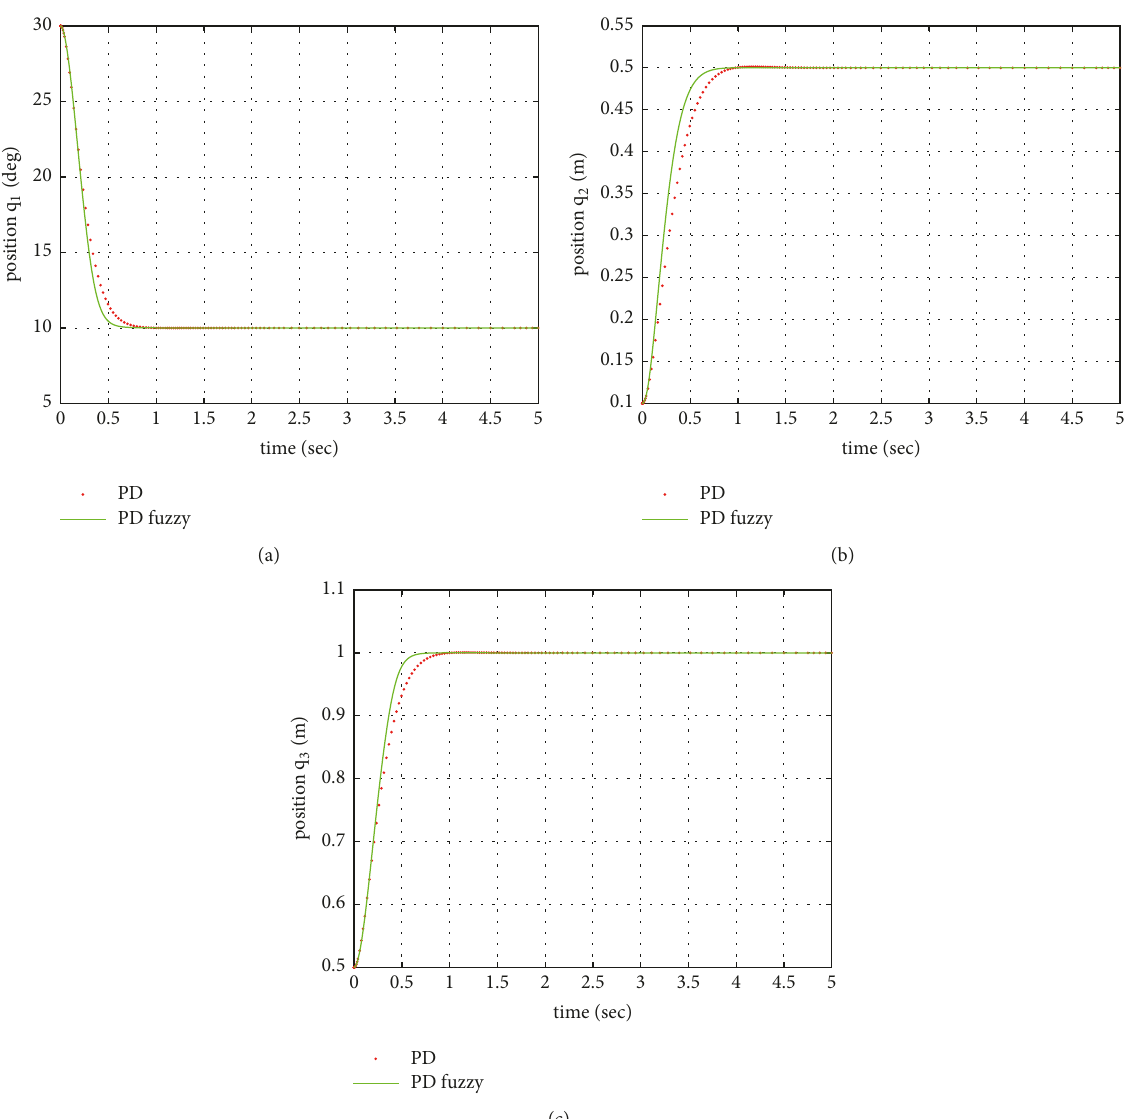
Figure 4: The position diagram of each of the links controlled via optimal fuzzy PD and optimal PD controllers, (a) the position of the first link (revolute), (b) the position of the second link (prismatic), and (c) the position of the third link